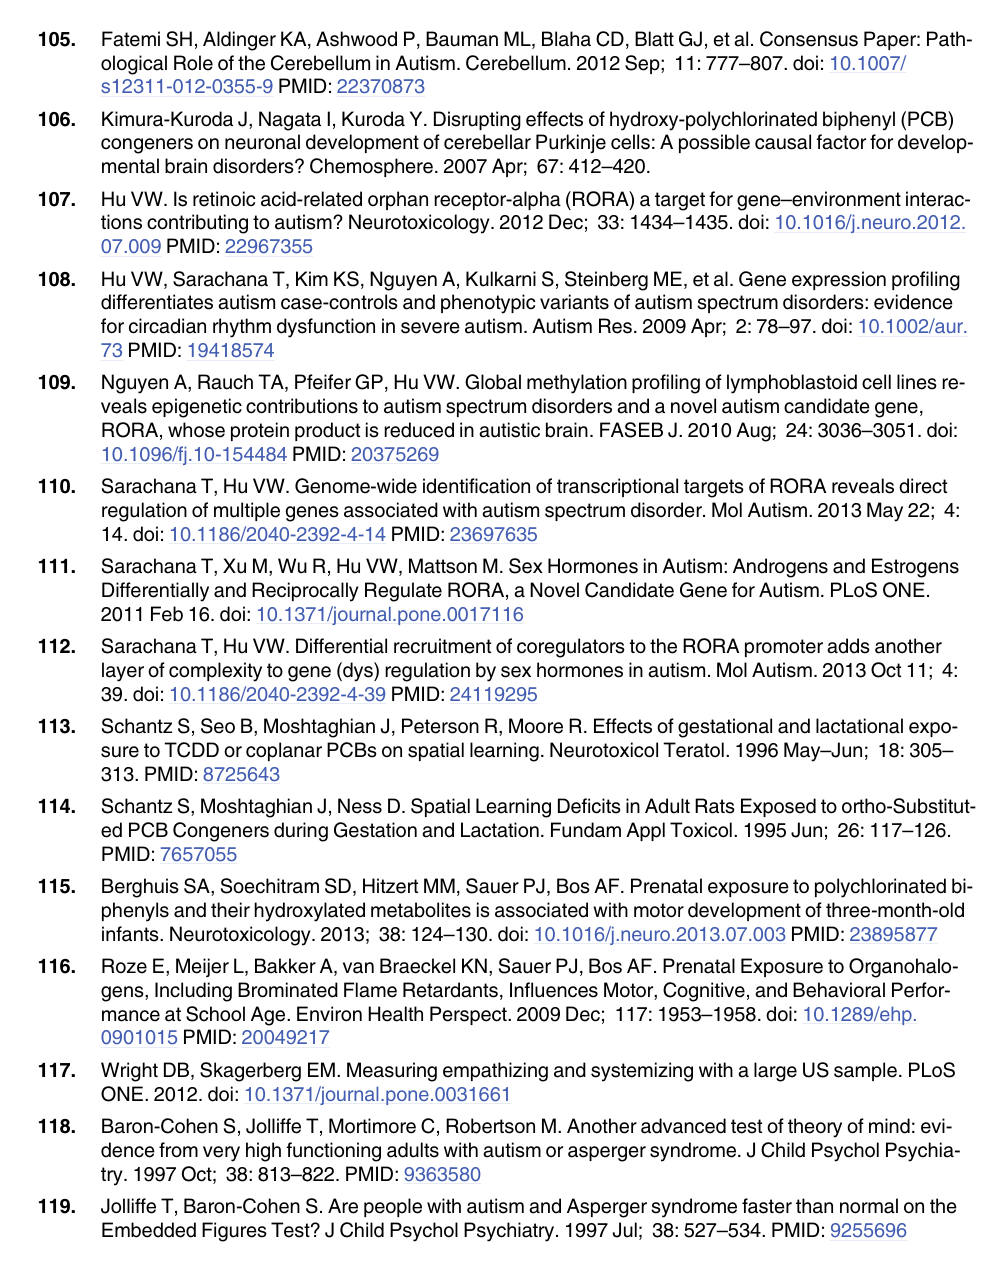
PLOS ONE | DOI:10.1371/journal.pone.0129906 June 12,